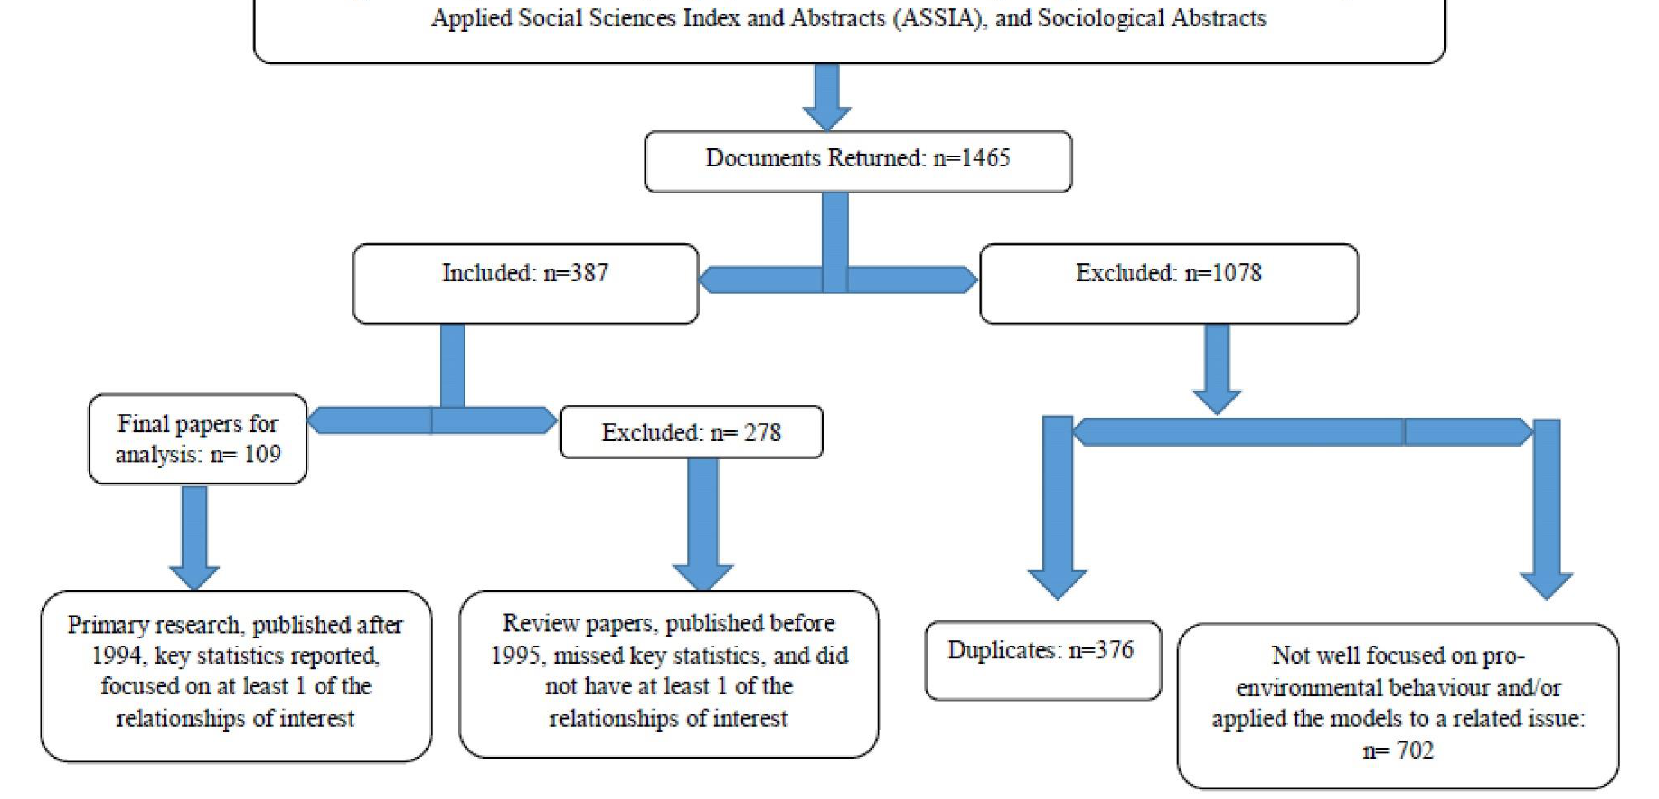
Figure 3. Document Selection Process.